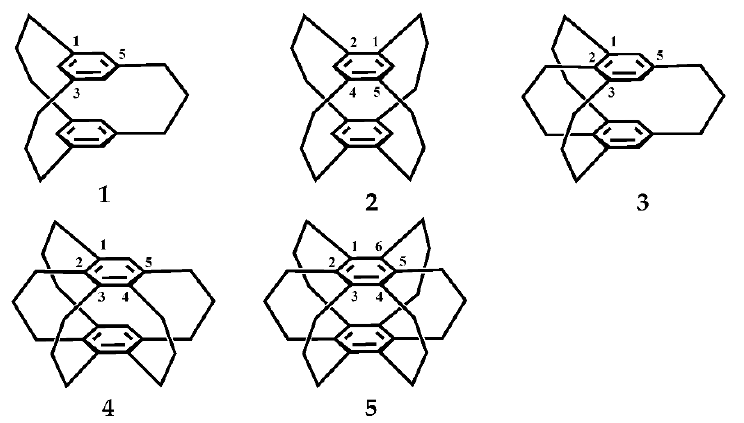
Figure 2. The structure diagrams of [3 3 ](1,3,5)CP 1 , [3 4 ](1,2,4,5)CP 2 , [3 4 ](1,2,3,5)CP 3 , [3 5 ](1,2,3,4,5)CP 4 , and [3 6 ](1,2,3,4,5,6)CP 5 .